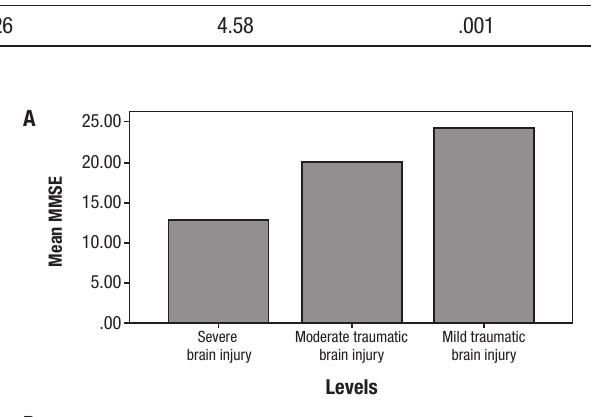
Table 2. Prediction of cognitive impairment by levels and causes of traumatic brain injury and education. Cognitive impairment B Beta Levels